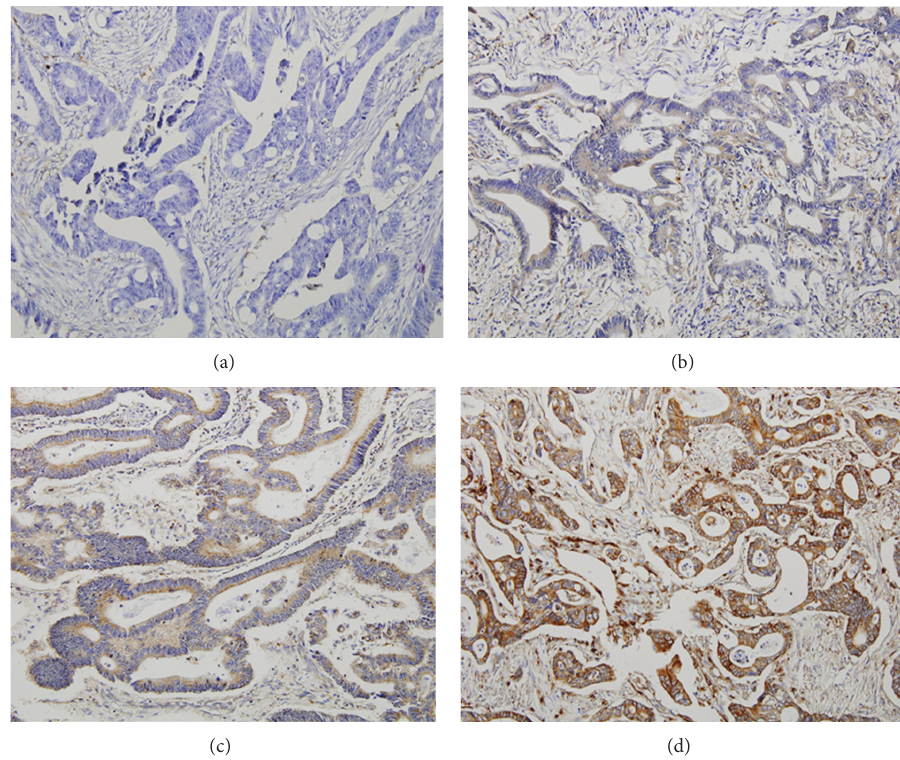
Figure 1: Representative microphotographs of DUSP4 immunostaining in colorectal adenocarcinoma ( × 200). (a) Negative, (b) weak, (c) moderate, and (d) strong. The tumor cells showed cytoplasmic DUSP4 staining.